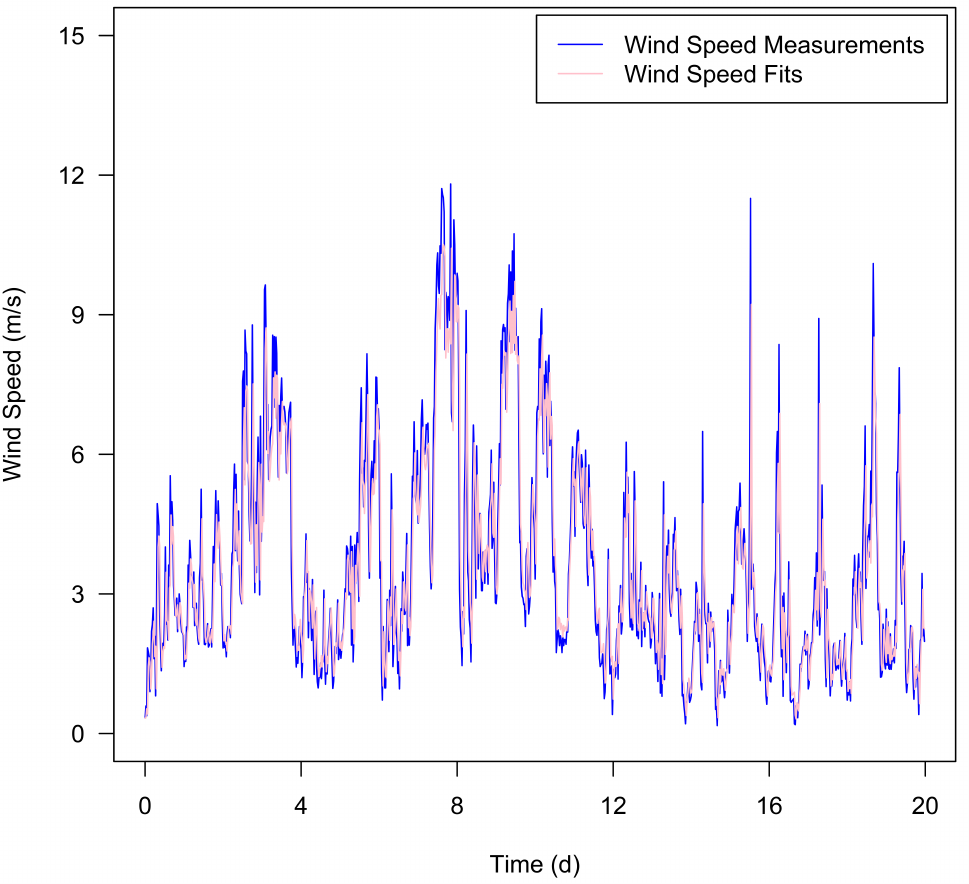
Figure 6. Comparison between the wind speed fits provided by the ARIMA ( 2,1,1 ) model and the historical wind speed measurements from the 20-day training